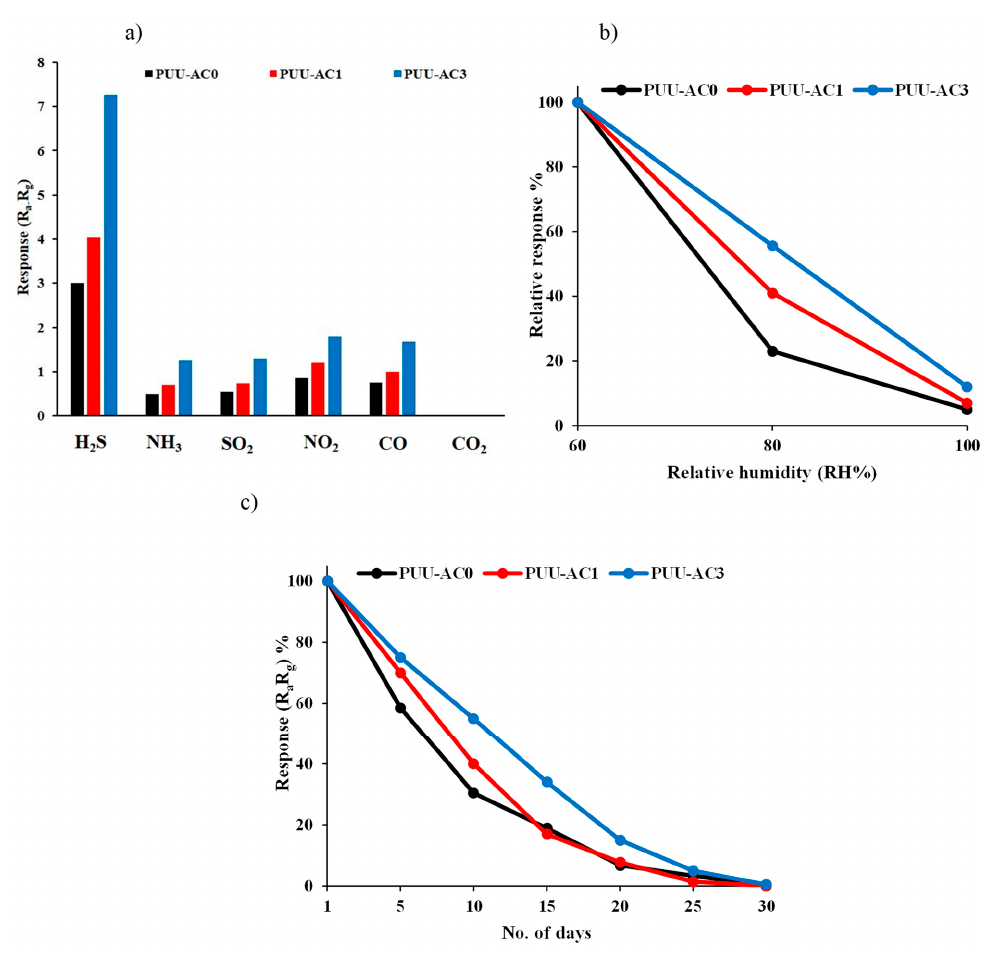
Figure 9. ( a ) Detection selectivity upon exposure to various vapors (20 ppm) operating at room tem- perature ( b ) The effect of relative humidity on sensor response and ( c ) stability of PUU-AC0, PUU- AC1 and PUU-AC3